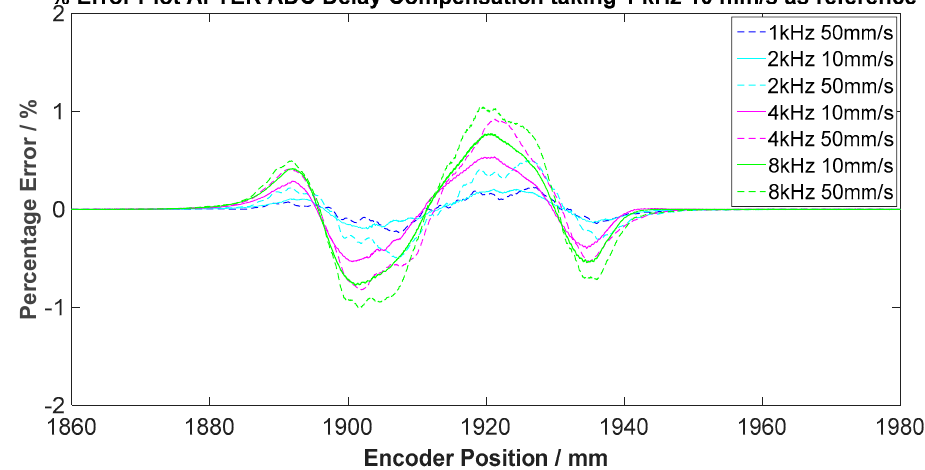
Figure 12. Percentage error plot obtained by applying interpolation on the 1 kHz 10 mm/s trajectory after delay compensation. Table 9. Percentage errors comparison before and after delay compensation was applied.